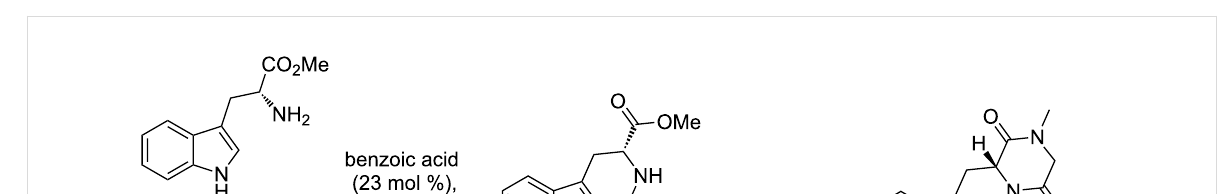
Scheme 27: Fischer indole synthesis of ondansetron.